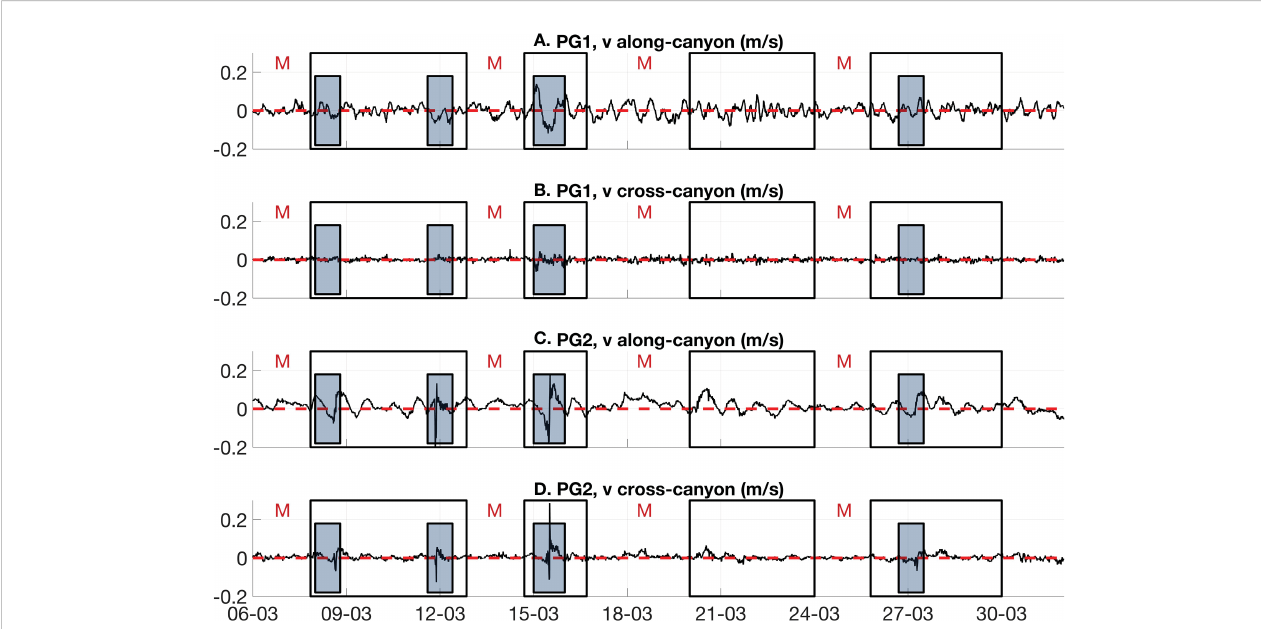
FIGURE 9 Averaged (A) along-canyon and (B) cross-canyon currents (m s – 1 ) measured by the PG1 mooring in March. Averaged (C) along-canyon and (D) cross- canyon currents (m s – 1 ) measured by the PG2 mooring in March. The fi lled gray boxes refer to speci fi c events. The black boxes correspond to the relaxation of Mistral events. ‘ M ’ refers to Mistral events occurring over the periods preceding the